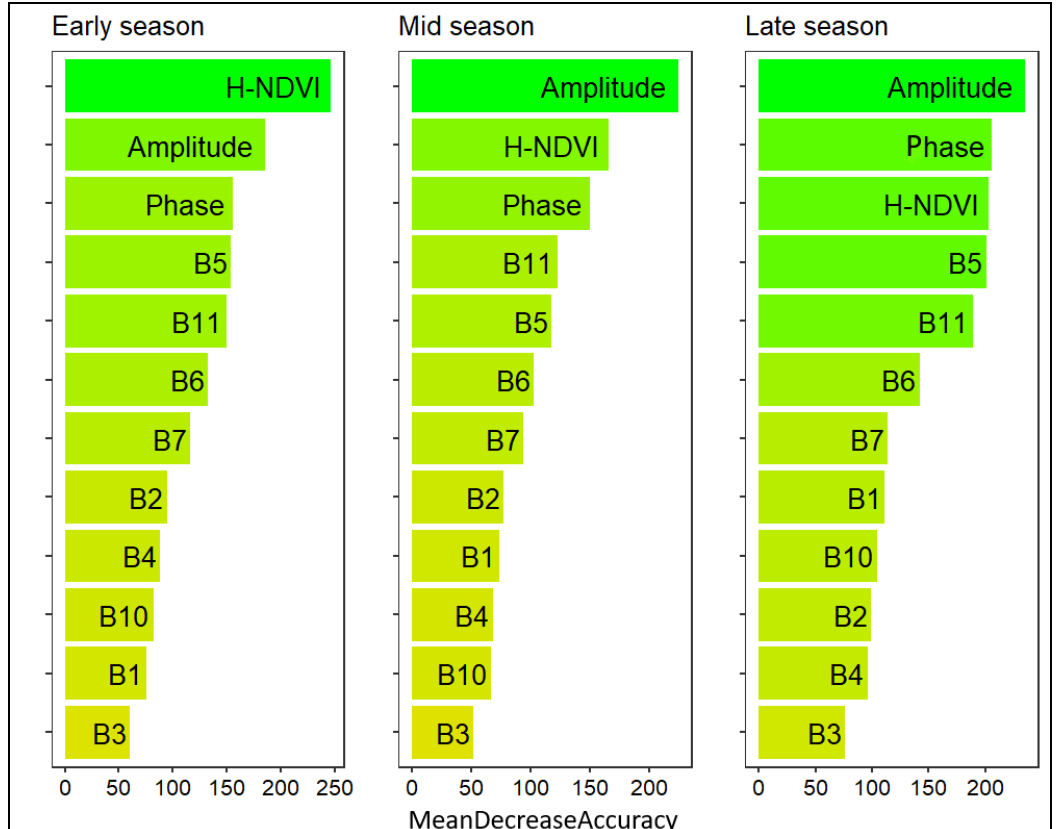
Figure 7. Variable importance of model 4. Model 4 used all metrics as variables in the model.